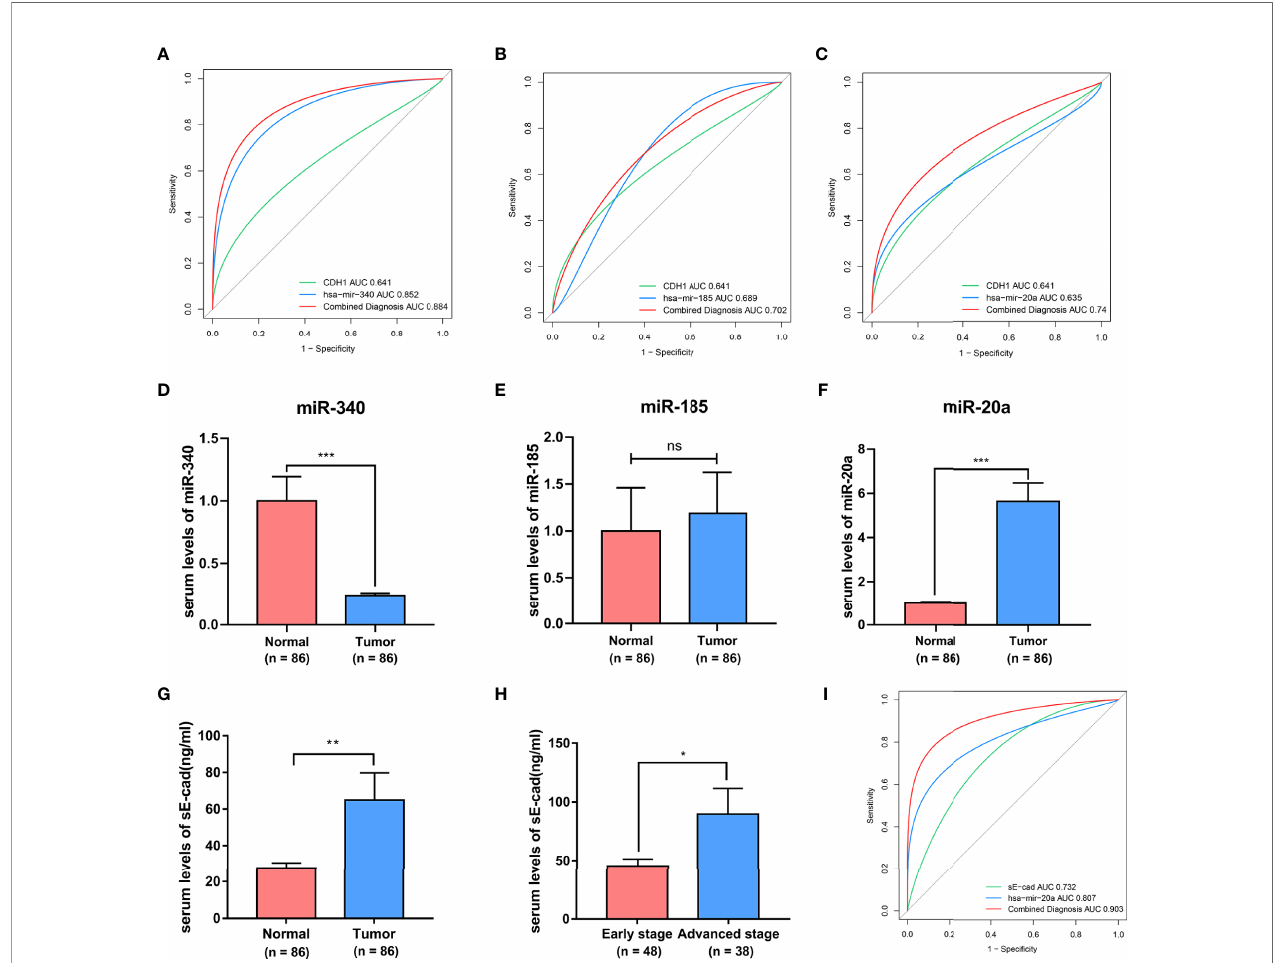
FIGURE 6 | The diagnostic signi fi cances of sE-cad and miR-340, miR-185, miR-20a in BC. (A – C) The ROC curves for the diagnostic value of the CDH1, miR-340, miR-185, and miR-20a in BC. (D – G) Serum miR-340, miR-185, miR-20a, and sE-cad expression levels in BC patients and healthy subjects. (H) sE-cad in serum levels of BC patients at different stages. (I) ROC curves of sE-cad in combination with miR-20a diagnostic model. * P < 0.05; ** P < 0.01; *** P < 0.001. no signi fi cant